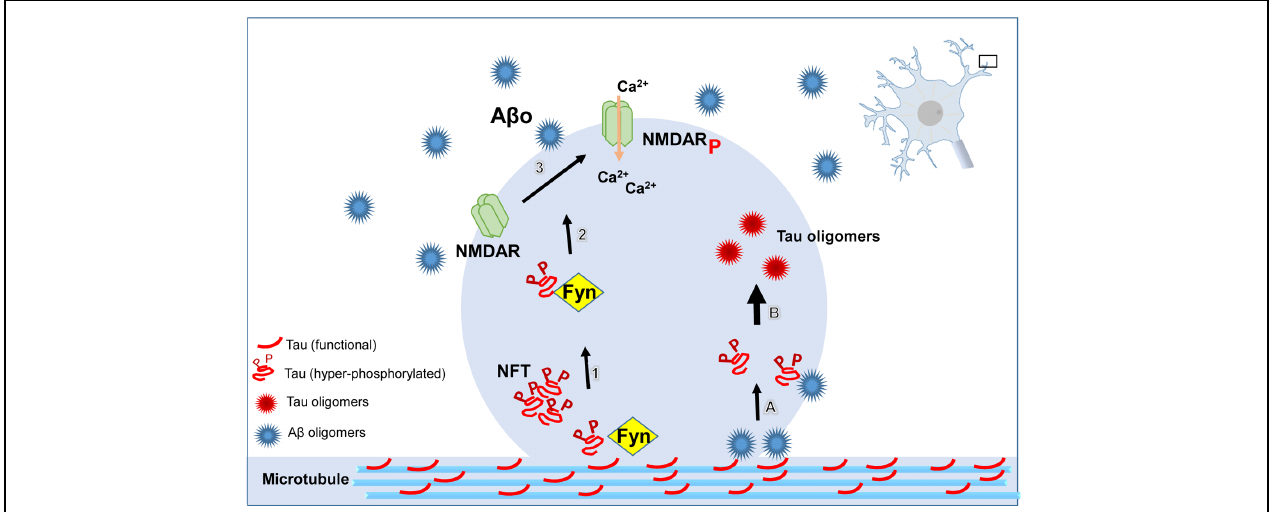
FIGURE 1 | Schematic illustrating the pathological role of tau at dendritic spines. ß-amyloid (A β ) oligomers directly or indirectly lead to the dystrophic changes in neurites mediated by tau. Hyperphosphorylated tau targets the kinase, Fyn, to the postsynaptic compartment. Fyn phosphorylates NR2B, a subunit of the N-methyl- D -aspartate receptor (NMDAR), resulting in the over-activation of NMDAR, followed by increased concentration of Ca 2 + in the cytoplasmic compartment. A β oligomers (A β o) seed tau misfolding and aggregation by direct interaction resulting in tau oligomer formation at dendritic spines. All of these pathways converge in the aggregation of tau protein, spine loss, and consequently, cognitive